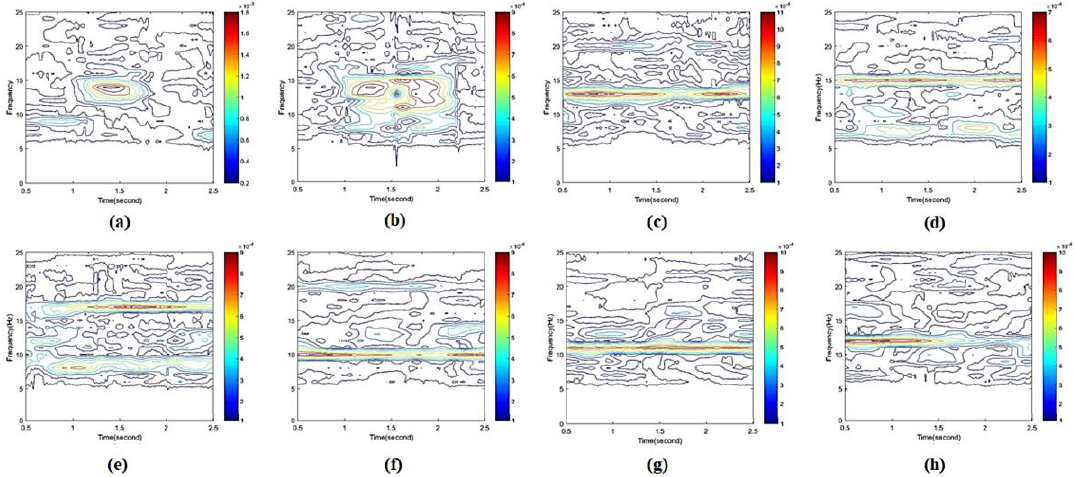
Figure 8. STFT features for ( a ) single eye blink, ( b ) double eye blink, ( c ) SSVEP at 6.6 Hz, ( d ) SSVEP at 7.5 Hz, ( e ) SSVEP at 8.57 Hz, ( f ) SSVEP at 10 Hz, ( g ) SSVEP at 11 Hz, and ( h ) SSVEP at 12 Hz.